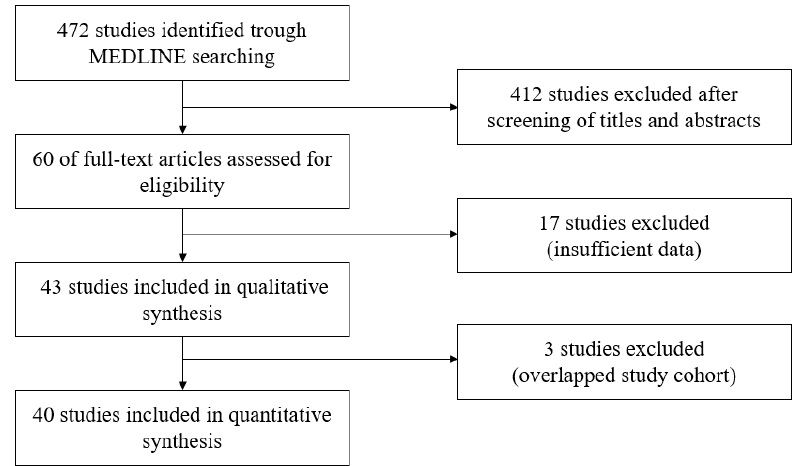
Figure 1. A flow diagram of the inclusion criteria of studies eligible for meta-analysis.